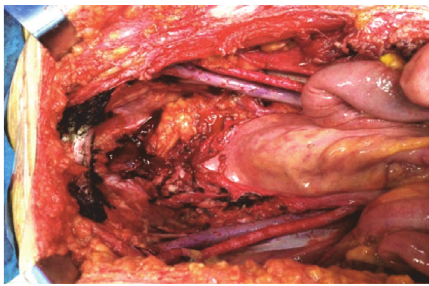
Figure 1: Intraoperative